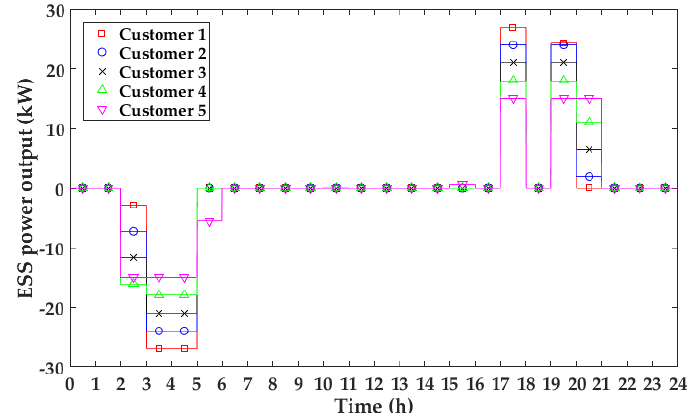
Figure 12. ESS charging schedule in Case 2 on Day 2.